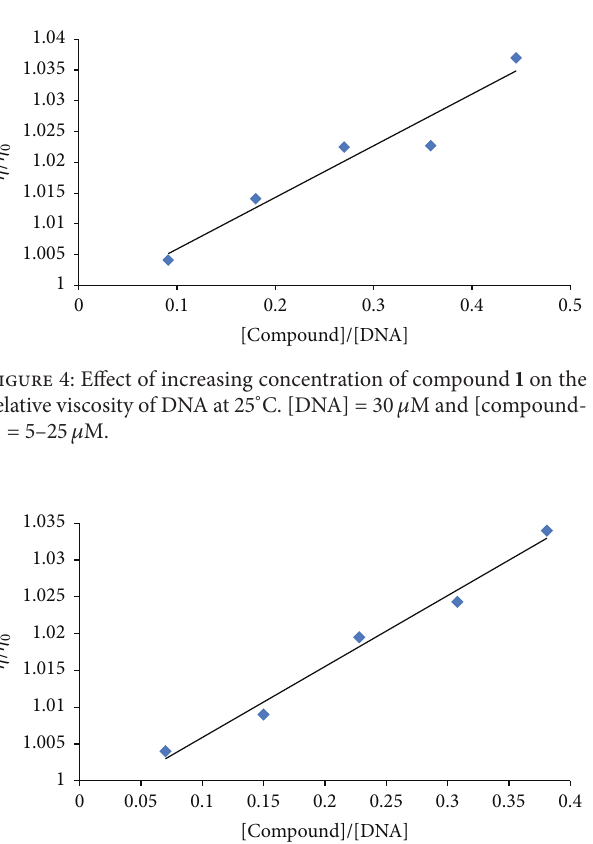
Figure 5: Effect of increasing concentration of compound 5 on the relative viscosity of DNA at 25 ∘ C. [DNA] = 30 𝜇 M and [compound- 5] = 5–25 𝜇